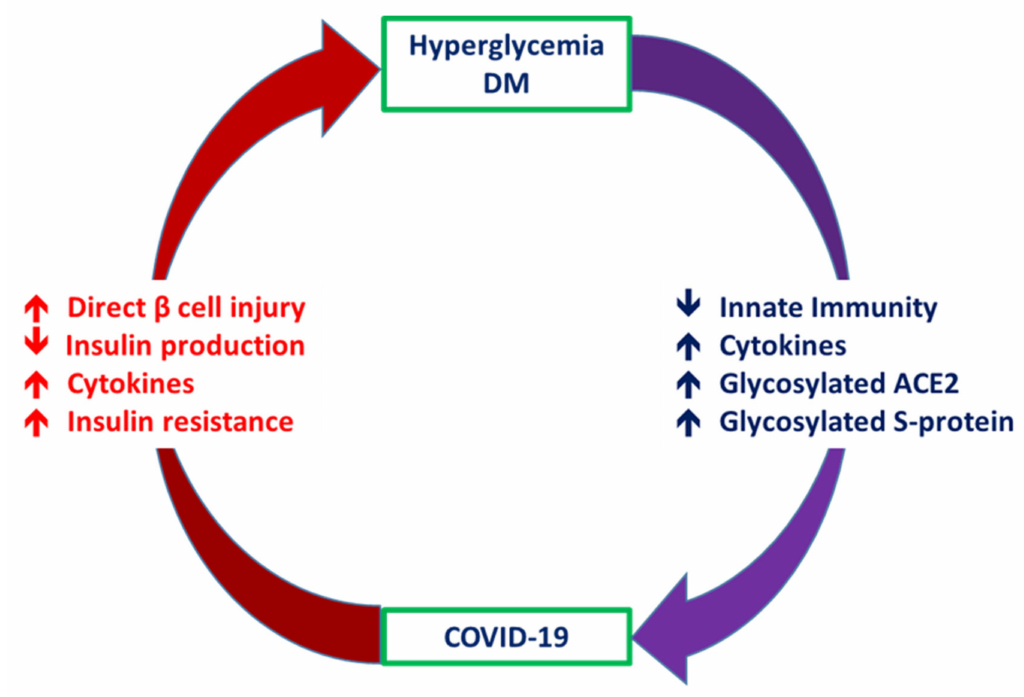
Figure 3. Crosslink between Coronavirus disease 2019 (COVID-19) and diabetes